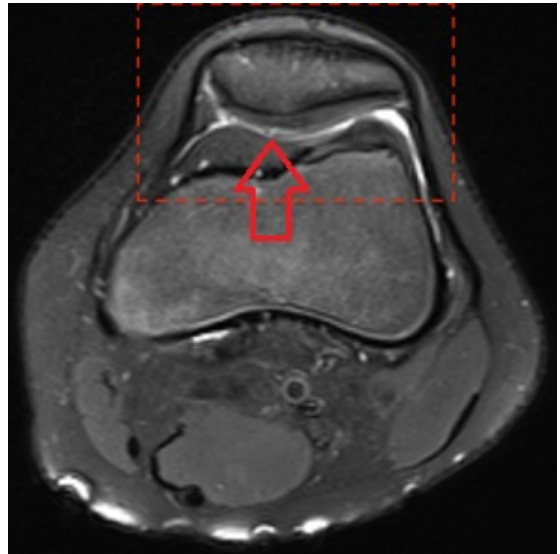
Figure 1. Patellar cartilage rupture.